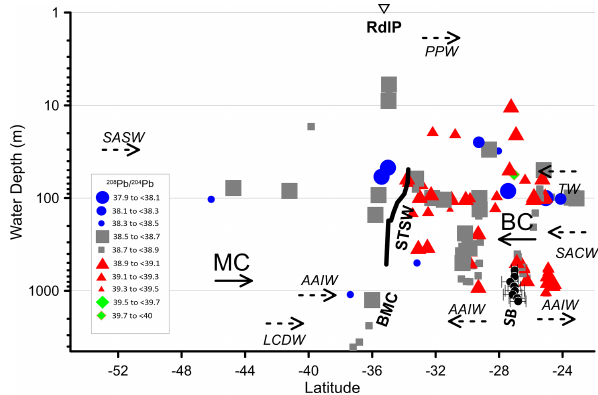
Figure 9. Latitudinal and bathymetric variability of 208 Pb / 204 Pb in the sector between 23 and 55 ◦ S. Río de la Plata (RdlP). Wa- ter masses: Plata Plume Water (PPW), Subantarctic Shelf Wa- ter (SASW), Tropical Water (TW), South Atlantic Central Water (SACW), Antarctic Intermediate Water (AAIW), and Lower Cir- cumpolar Deep Water (LCDW). Currents: Malvinas Current (MC) and Brazil Current (BC). Fronts: Subtropical Shelf Front (STSW), Brazil–Malvinas Confluence (BMC), and Santos Bifurcation (SB). Vertical axis in log ( 10 )